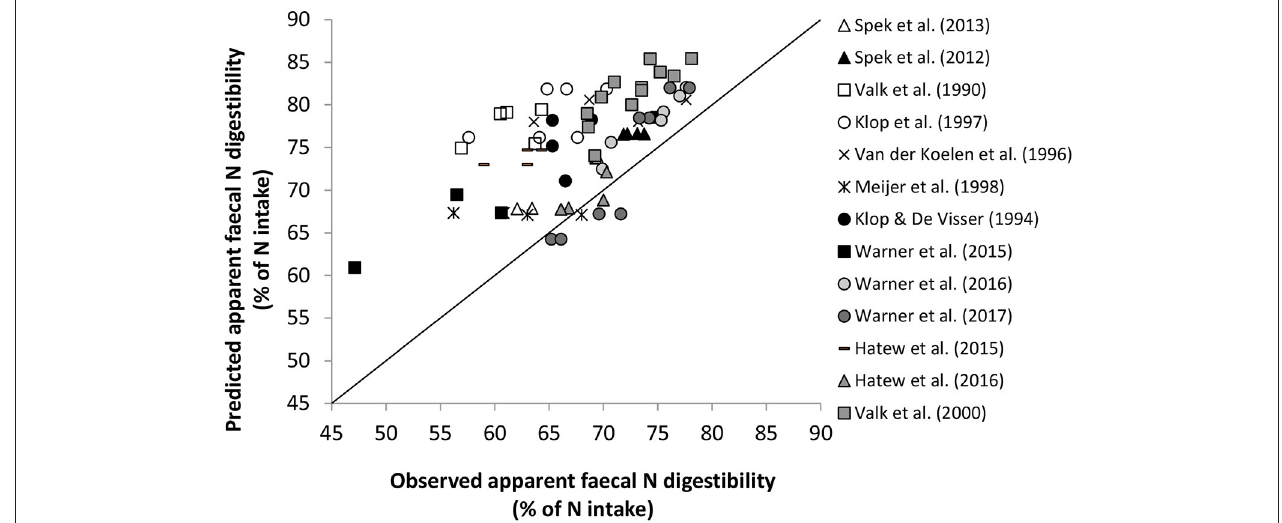
FIGURE 1 | A preliminary evaluation of prediction of apparent fecal N digestibility (% of N intake) by the CVB model for 13 Dutch trials with lactating cows on 69 dietary treatments. Observational data were retrieved from 10 studies published in journals ( Valk et al., 1990, 2000; Spek et al., 2012, 2013; Hatew et al., 2015, 2016; Warner et al., 2015, 2016, 2017 ), and from 3 studies on the modulating effect of starch supplementation at various sites in the gastrointestinal tract on apparent N digestibility, reported in 4 internal documents (Klop and de Visser, 1994; Van der Koelen et al., 1996; Klop et al., 1997; Meijer et al., 1998). Dry matter (DM) intake ranged from 14.5 to 22.5 kg/d, crude protein content in dietary DM from 8.4 to 24.4%, roughage fraction in dietary DM from 0.45 to 0.91, and observed apparent fecal N digestibility from 47.1 to